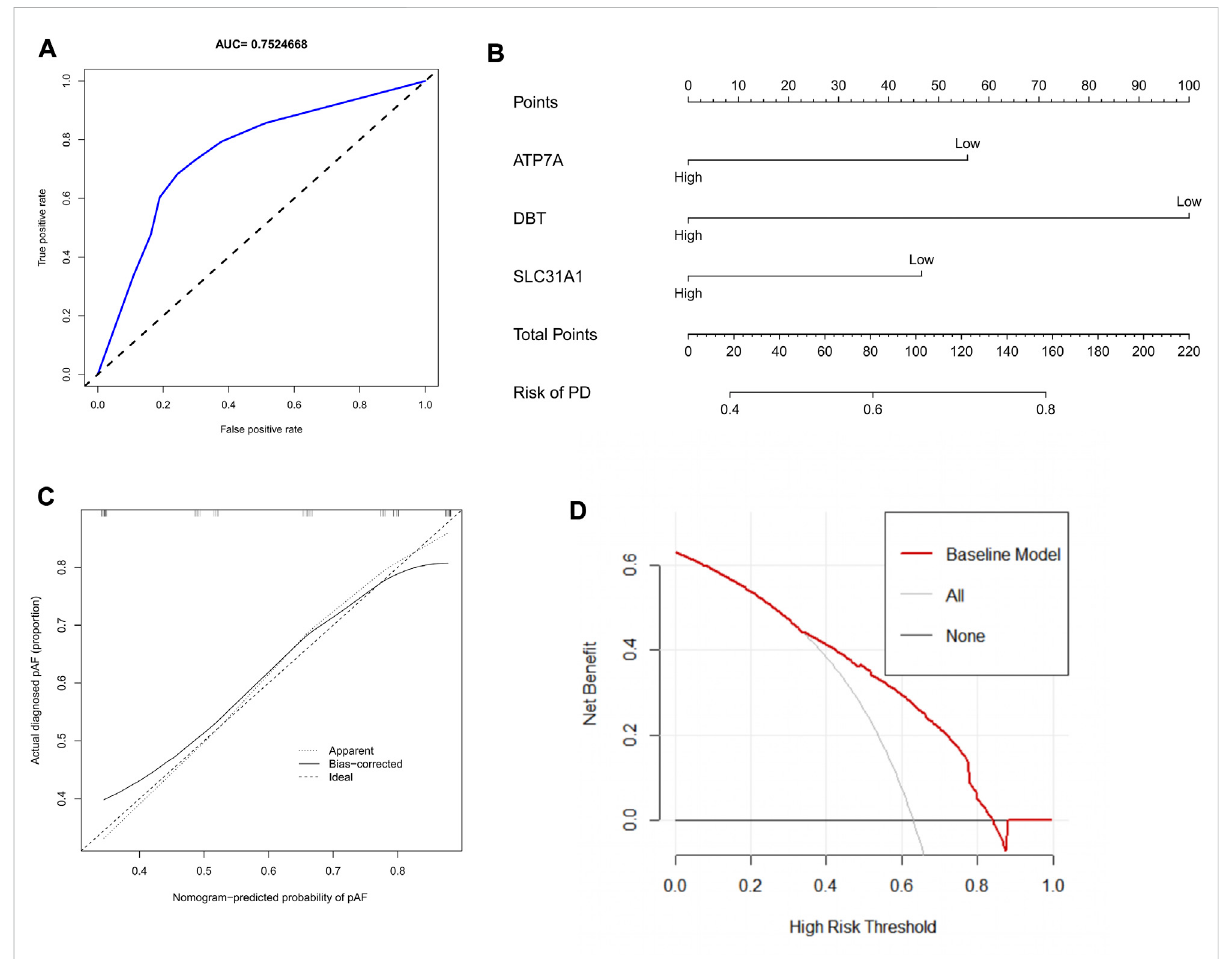
FIGURE 5 Construction of column line graph based on Characteristic CRGs. (A) The ROC curves estimating the diagnostic performance of characteristic genes. (B) Construction ofcolumnline graph integrating Characteristic CRGs for PD. in thecolumn linegraph,each variable correspondsto ascore, andthetotalscorecanbecalculatedbysummingthescoresofallvariables. (C) Calibrationcurvestoestimatethepredictionaccuracyofthecolumn line graphs. (D) Decision curve analysis showing the clinical bene fi t of column line